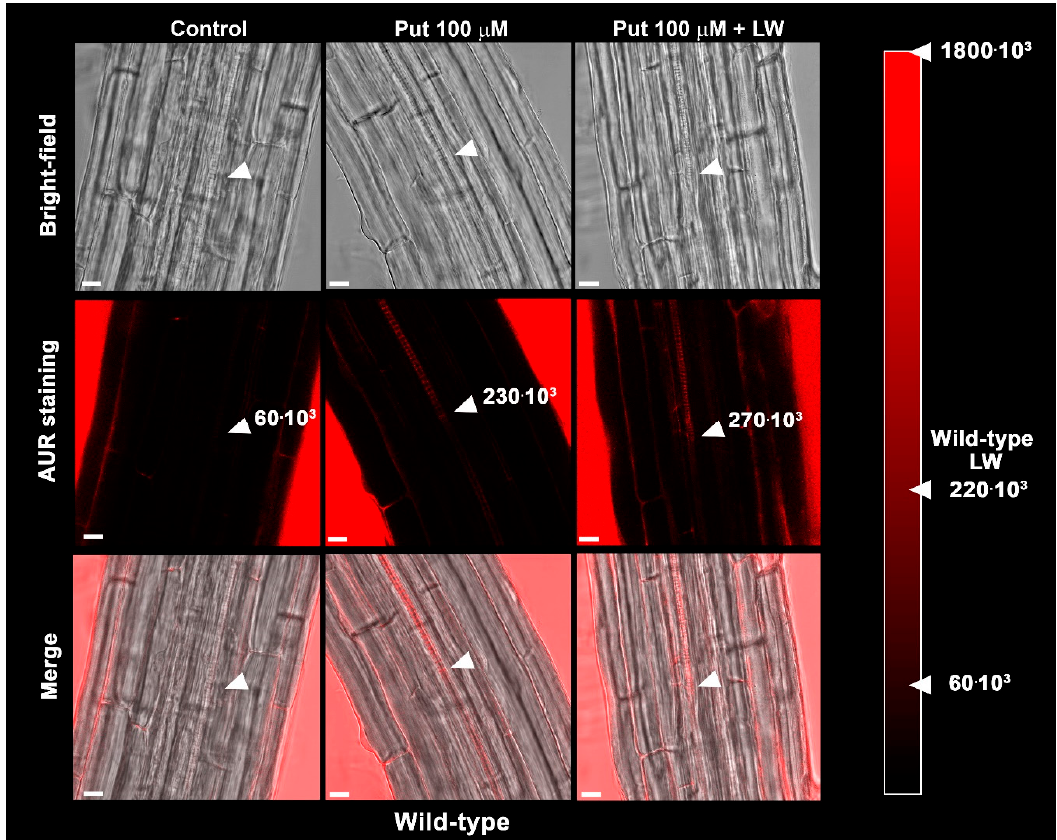
Figure 5. In situ H 2 O 2 detection by LSCM analysis, after AUR staining, of roots from 7 ‐ day ‐ old unwounded Put ‐ untreated control (Control), unwounded Put ‐ treated (Put 100 μ M) and leaf ‐ wounded Put ‐ treated (Put 100 μ M + LW) WT seedlings. Treatment with 100 μ M Put was performed 6 h after the injury. The corresponding bright ‐ field and overlay images are shown. Micrographs show the root zone corresponding to the site of appearance of the first protoxylem cell with fully developed secondary cell wall thickenings (arrows) and have been taken at the level of the central root section. Images are representative of those obtained from ten seedlings from three independent experiments. The average values of fluorescence intensity measured as the sum of the pixels of each of five 65 μ m 2 rectangle are reported for each condition (mean values ± SD; n = 25). The maximum pixel sum for a completely saturated square was approximately 1800 × 10 3 . In the red degrading scale are reported for comparison the average values of fluorescence intensity for leaf ‐ wounded (Put ‐ untreated) WT plants, respectively, were 60 × 10 3 ± 19 × 10 3 and 220 × 10 3 ± 38 × 10 3 (data from [10]). Bars: 10 μ m.